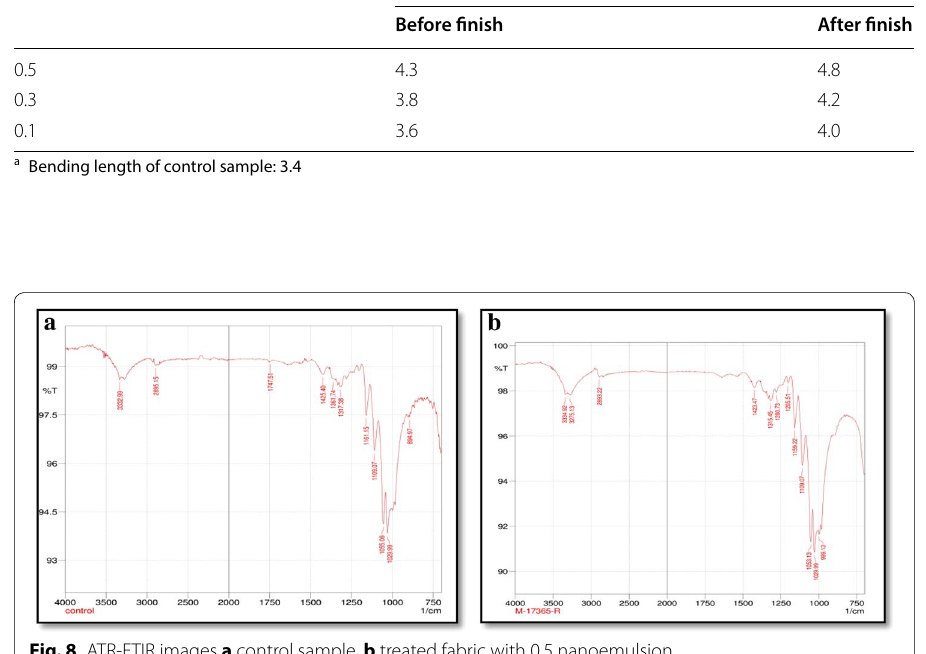
Table 7 Bending length of treated and untreated samples